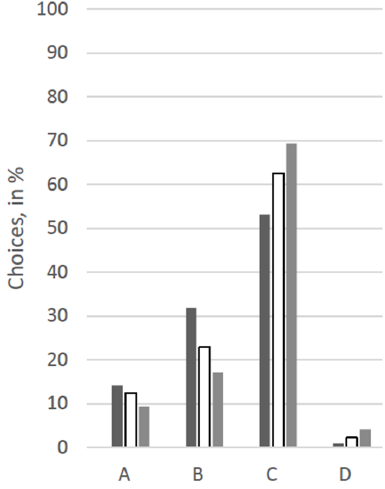
Figure 1. Answers for the scenario “70-year-old human” in %. Legend: black: human medicine group; white: control group; grey: veterinary medicine group; A: Euthanasia tablet, B: Sedation tablet, C: Potentially curative tablet, D: No treatment